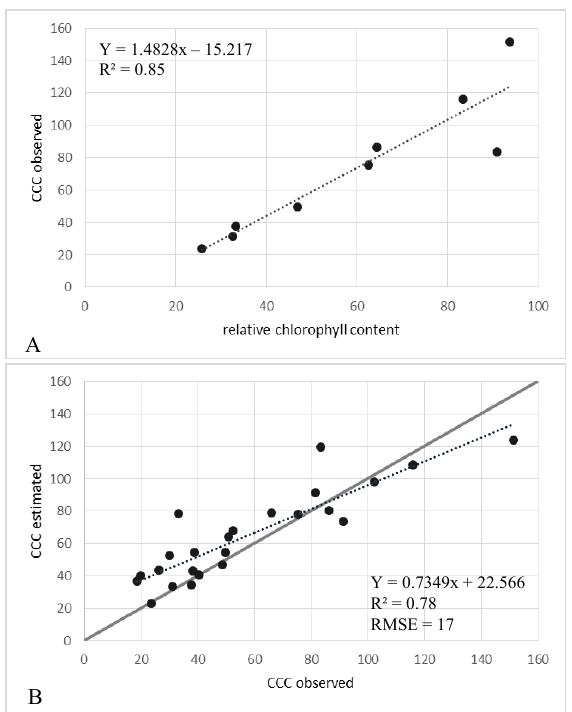
Figure 3. A: Calibration model to turn relative chlorophyll level values into CCC SPAD for the May data set. B: Estimated CCC est plotted vs. the corresponding observed CCC SPAD measurements on May 7 th 2011. The solid diagonal line represents the 1:1 line.